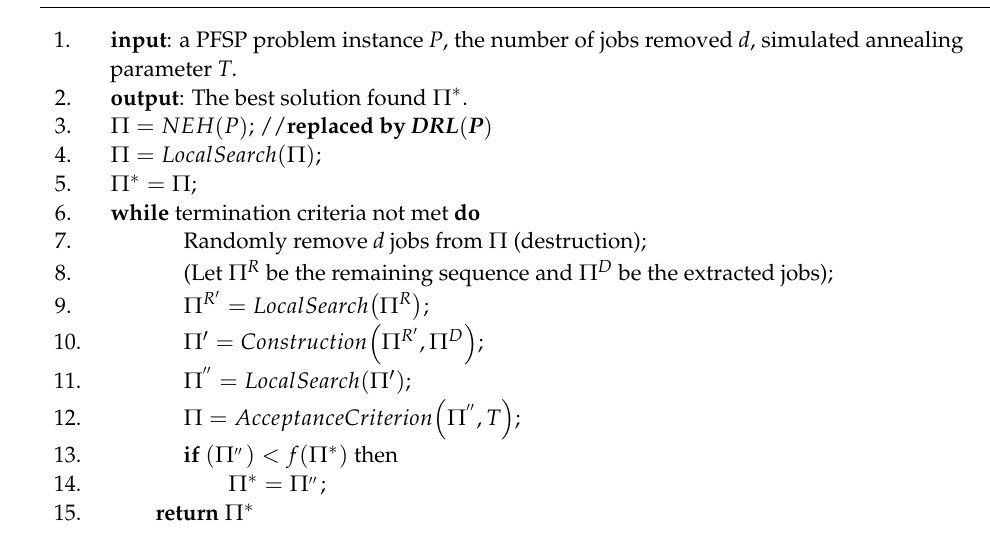
Algorithm 2 The IG framework with local